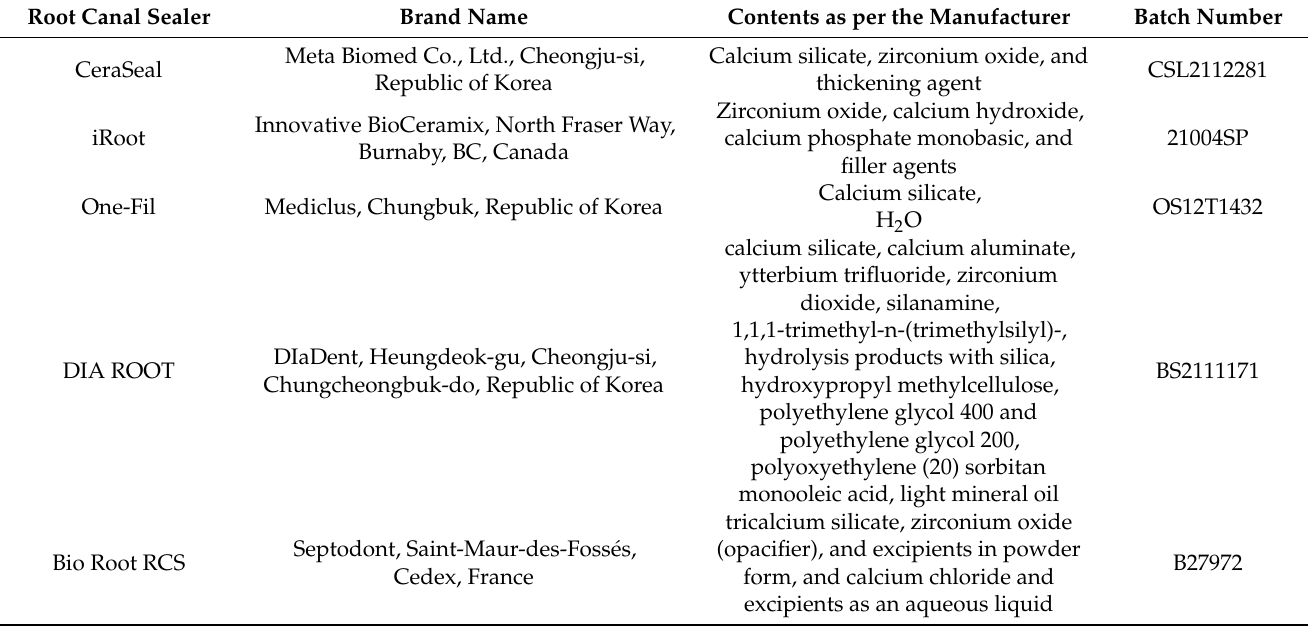
Table 1. Details of root canal sealers used in the current